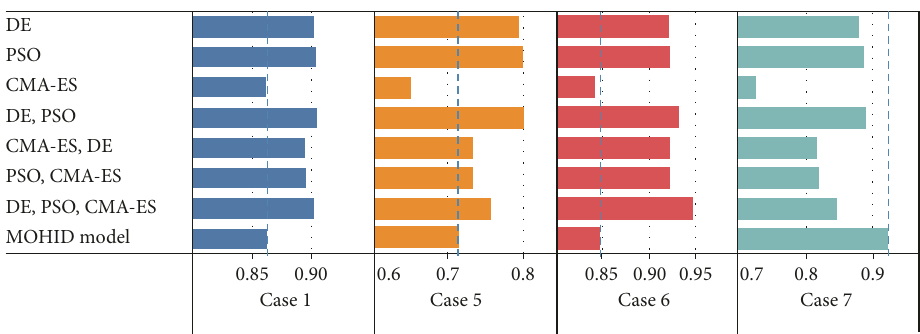
Figure 11: Bar graph of NCLS skill score for all the tested predictive models on four test cases. The higher the values, the better.